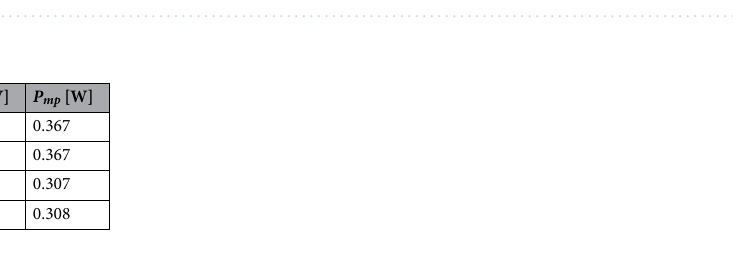
Table 2. First measurement of the characteristic